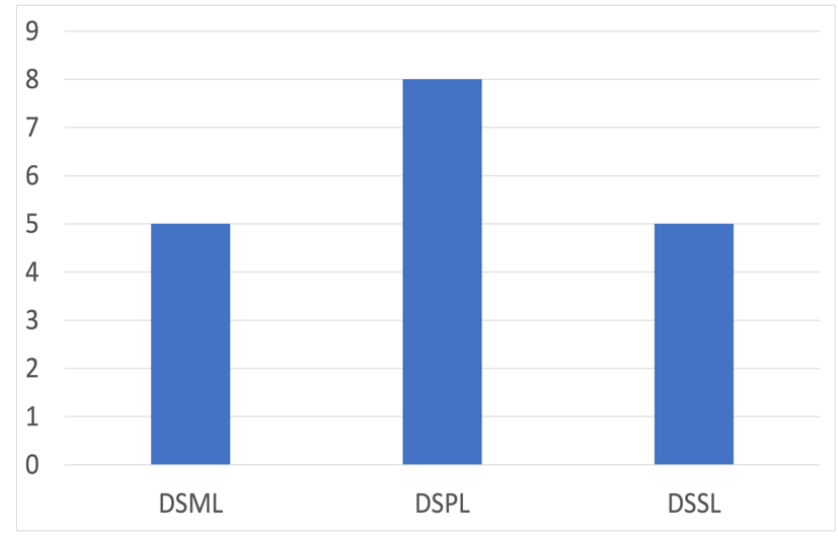
Figure 4. Number of studies in each DSL type.